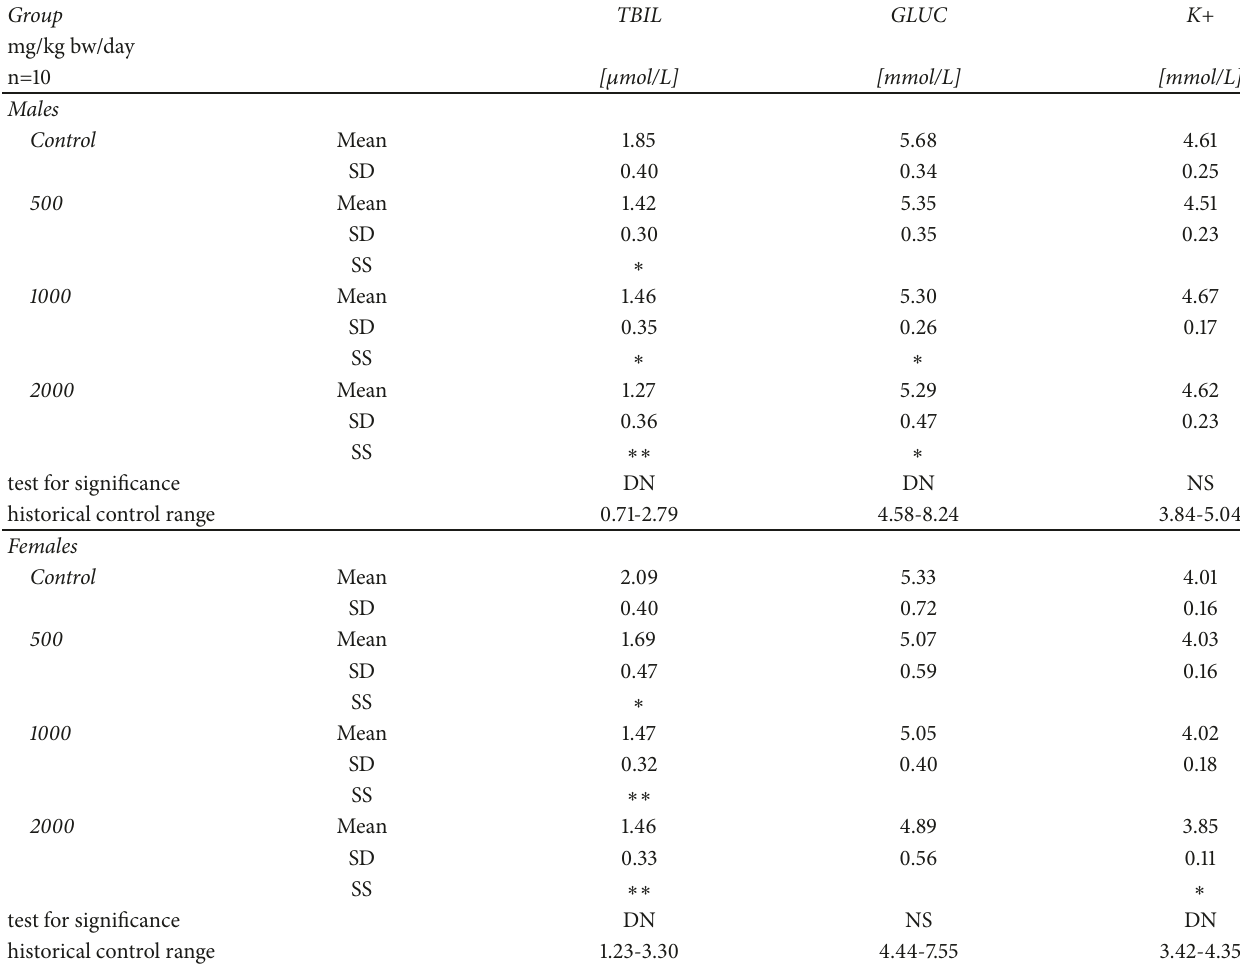
Table 6: Summary of relevant clinical chemistry findings in the 90-day